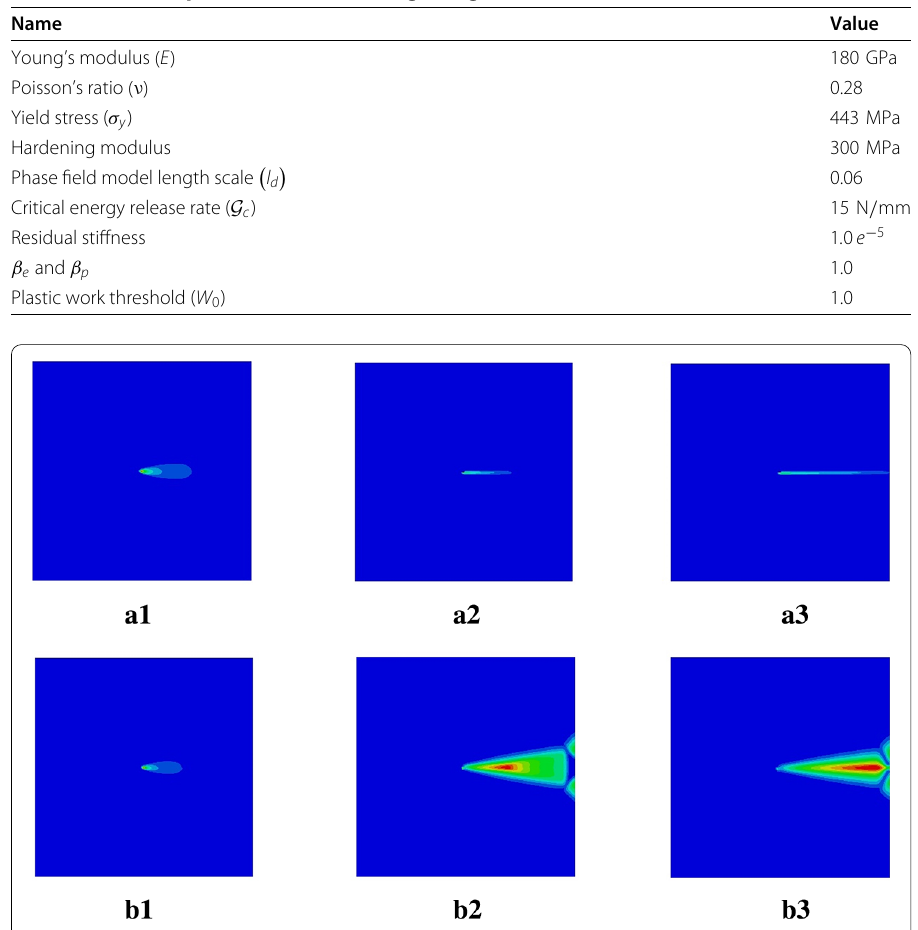
Fig. 9 Single edge notched test a geometry and boundary conditions b mesh discretization Table3 Material parameters for the single edge notched test